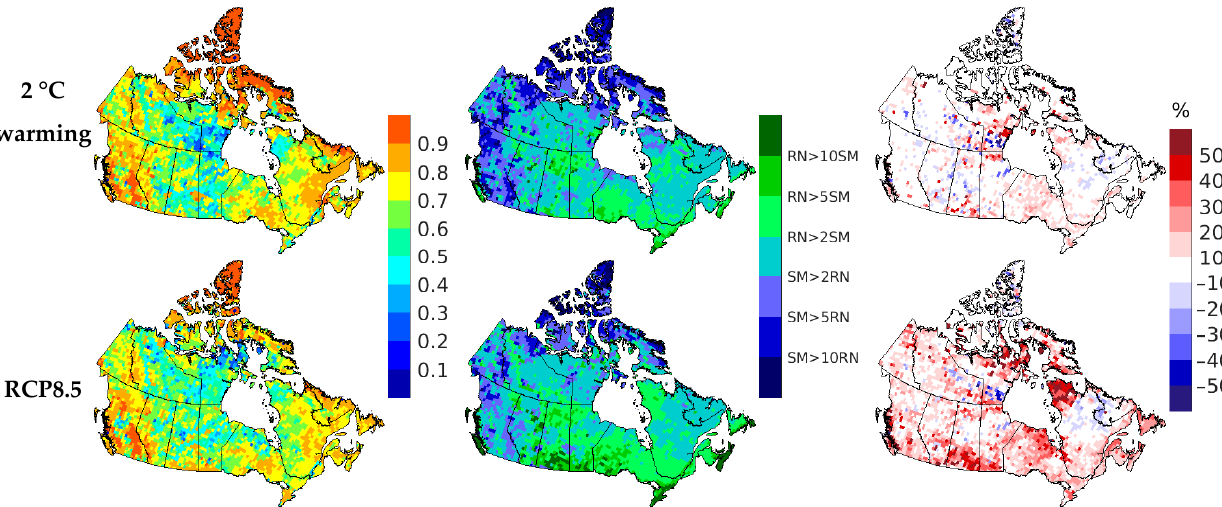
Figure 6. Correlation coefficient between streamflow and accumulated snowmelt/rainfall upstream of respective grid cell in GEM for the 150 largest streamflow events (first column), relative average snowmelt and rainfall contribution during those events (second column), and projected changes to the rainfall contribution during those events with respect to 1981–2010 (third column). Projections for both 2 °C warming (top row) and RCP8.5 2070–2099 (bottom row) are shown.